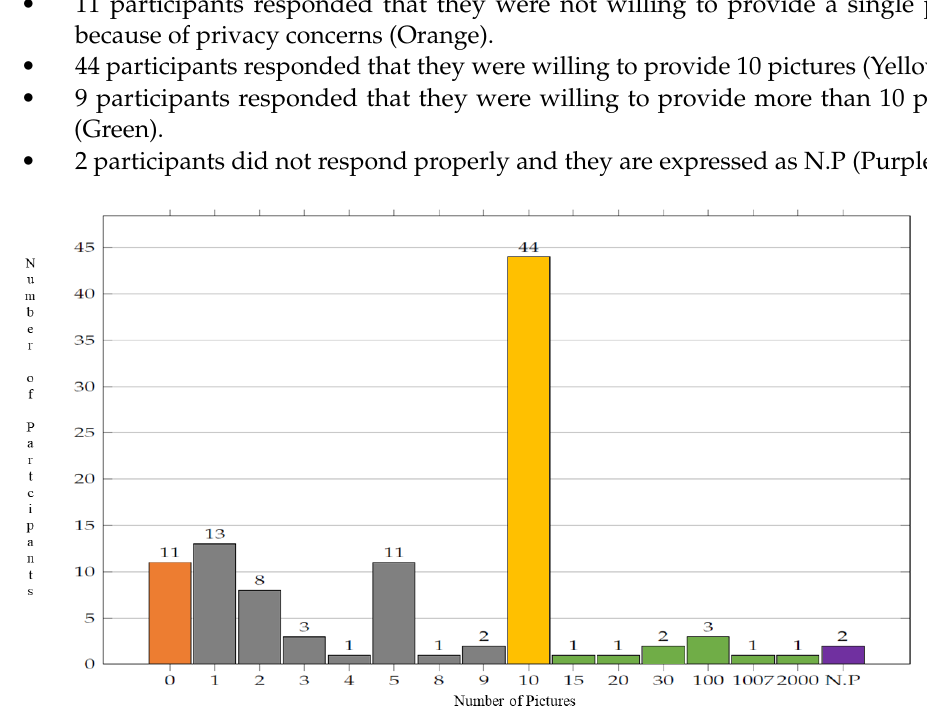
Figure 5. Survey results for N ( pic )